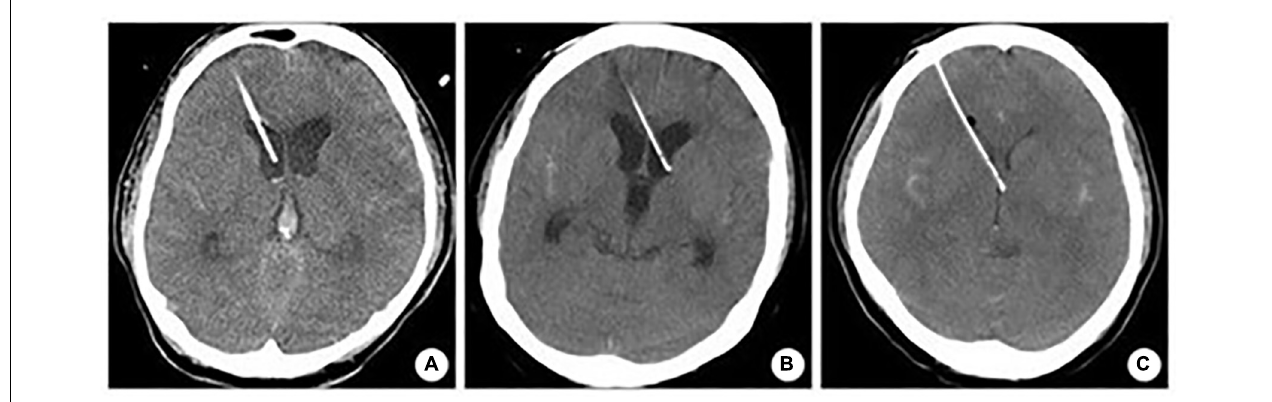
FIGURE 7 | Kakarla grading system. (A) Homolateral lateral ventricle positioning. (B) Contralateral lateral ventricle positioning. (C) Misplacement.